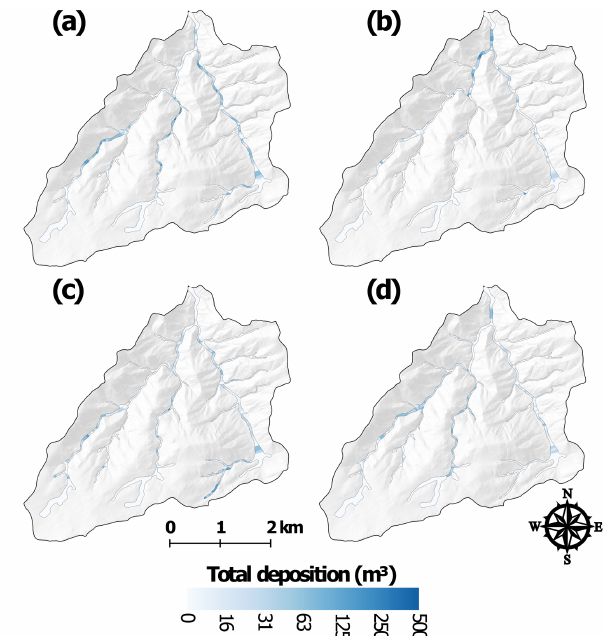
Figure A3. Total deposition for each valley bottom segment in Skin Gulch for (a) 201210–201307, (b) 201307–201310, (c) 201310–201409, and (d) 201409–201506. Calculated volumes are not reported for the transparent segments due to unrealistically wide valley widths, repeat excavations, or the ground surface not being reliably determined.